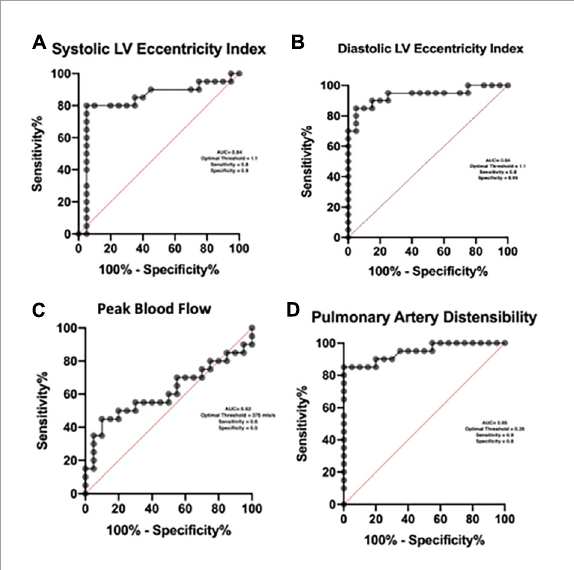
FIGURE4 ROC Curves used to identify diagnostic thresholds for novel CMR